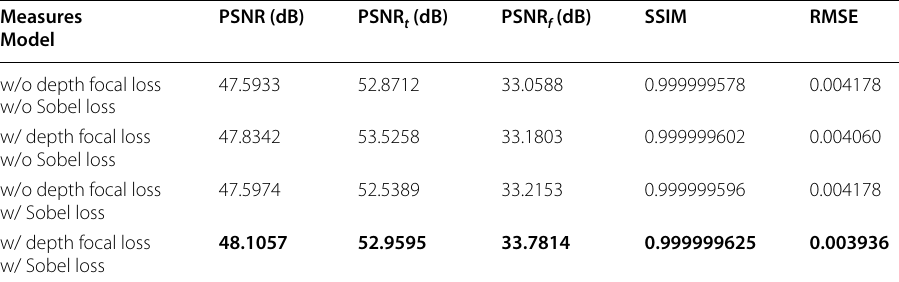
Table 2 Evaluation results of the proposed loss functions Measures Model